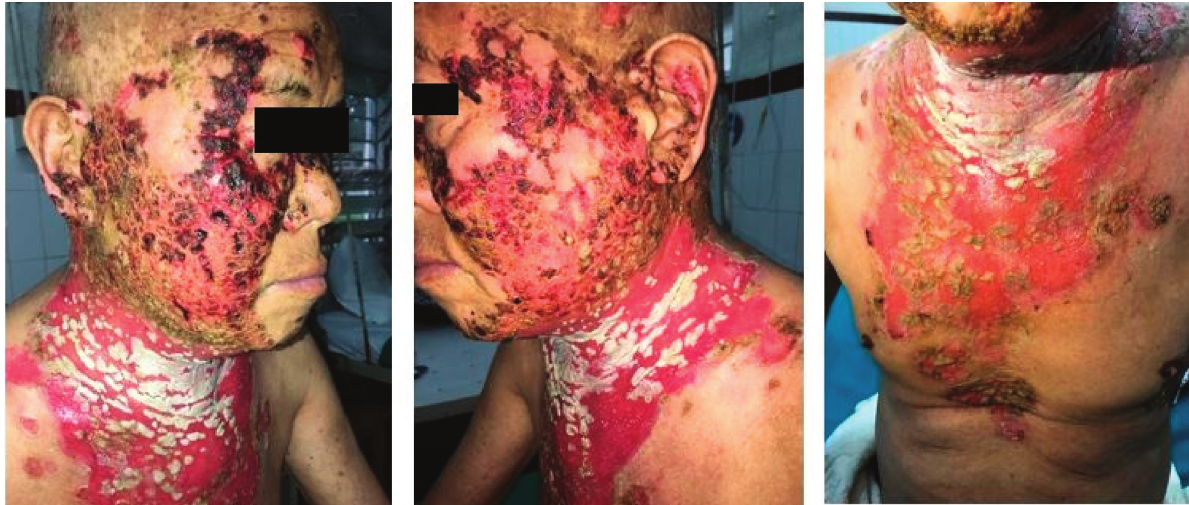
Figure 4: Day 23 of admission: extensive haemorrhagic crusts in the face and few in the periphery of erosions in the